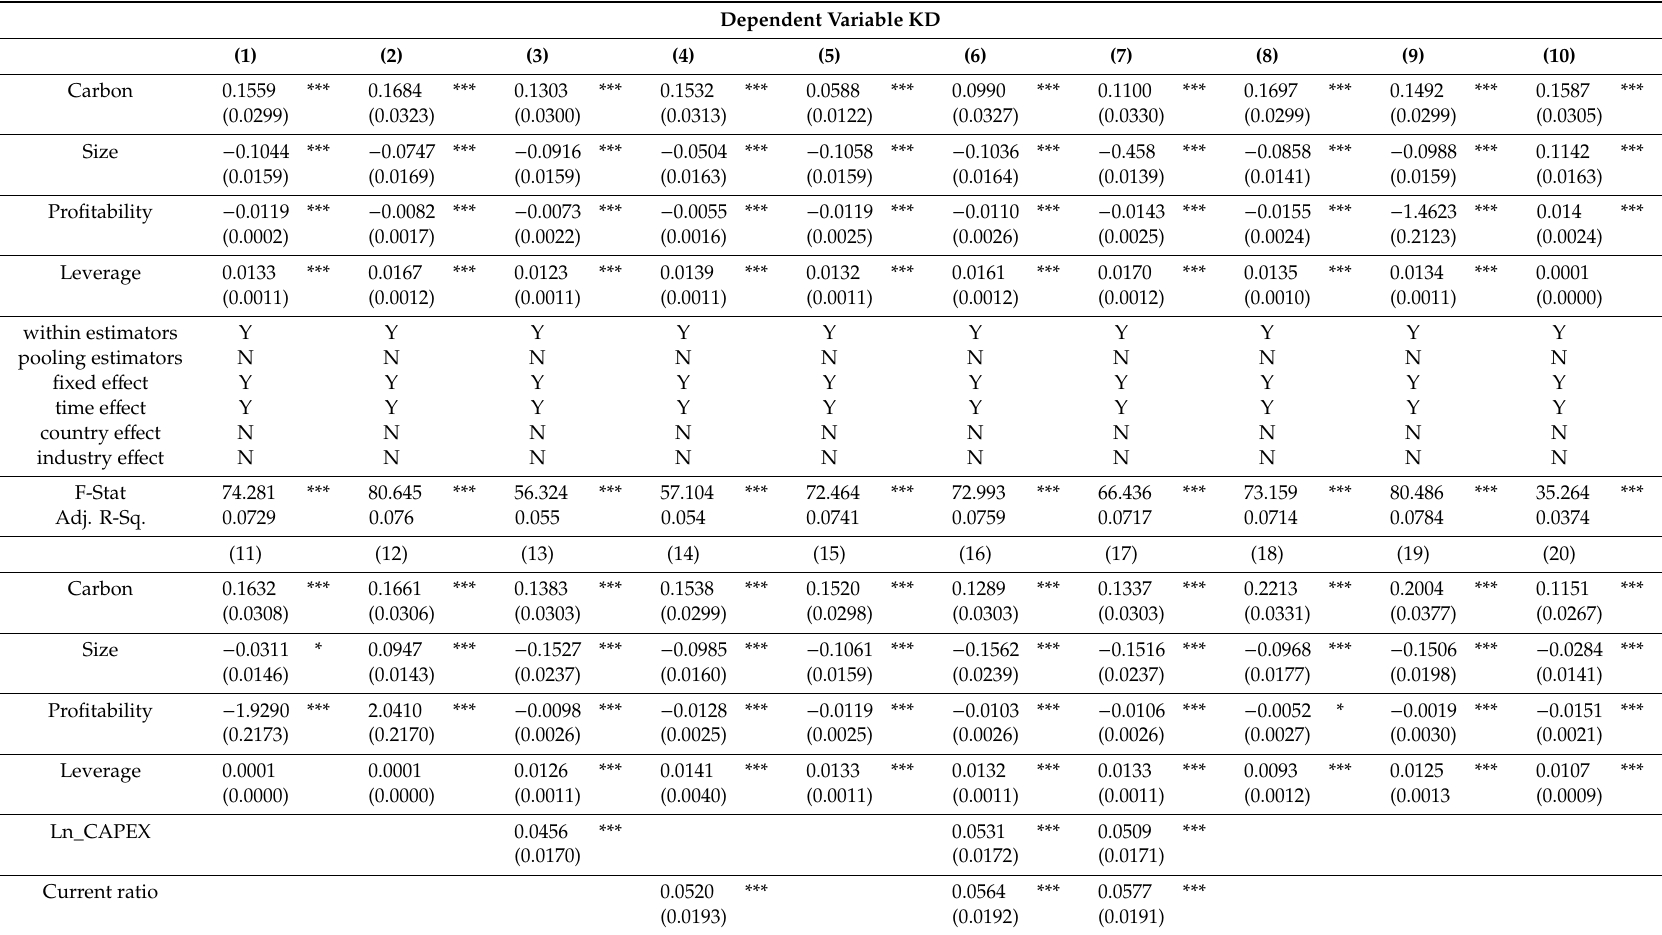
Table A1. Robustness checks regression